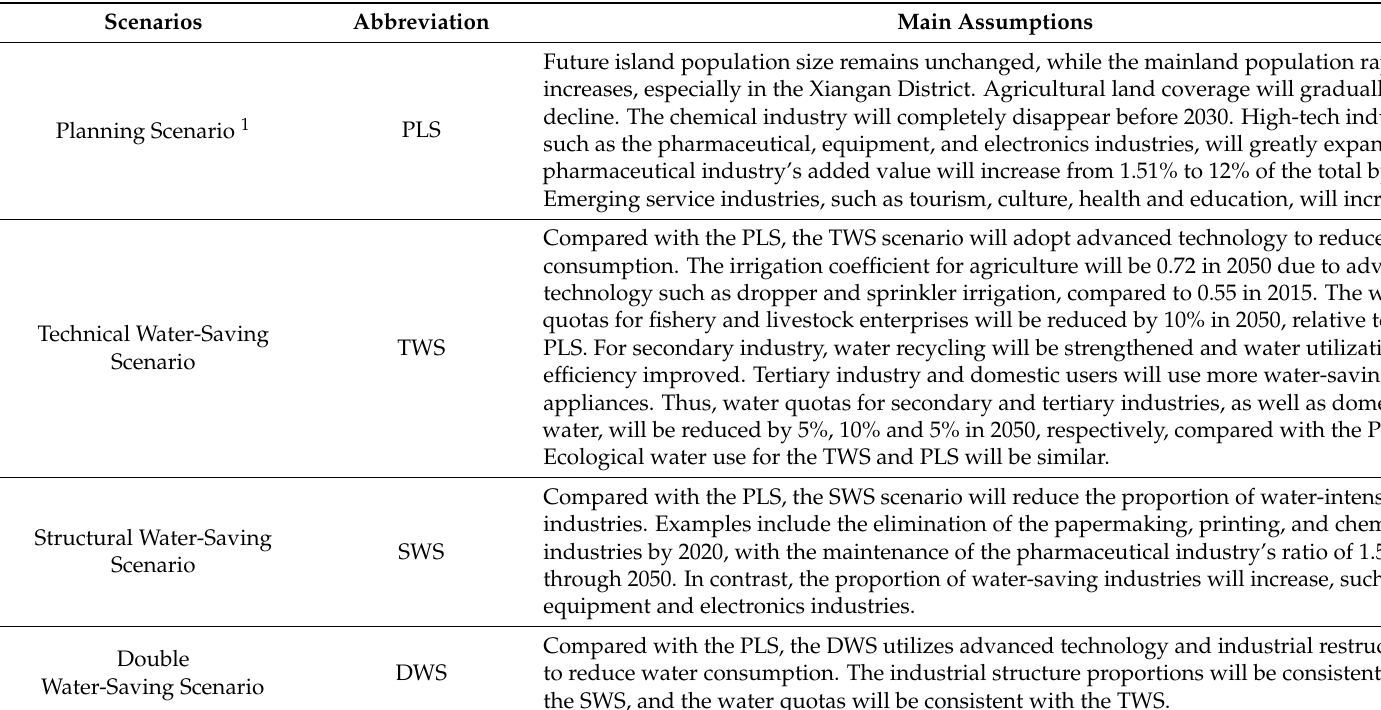
Table 2. Scenarios and assumptions of the Xiamen City WEAP